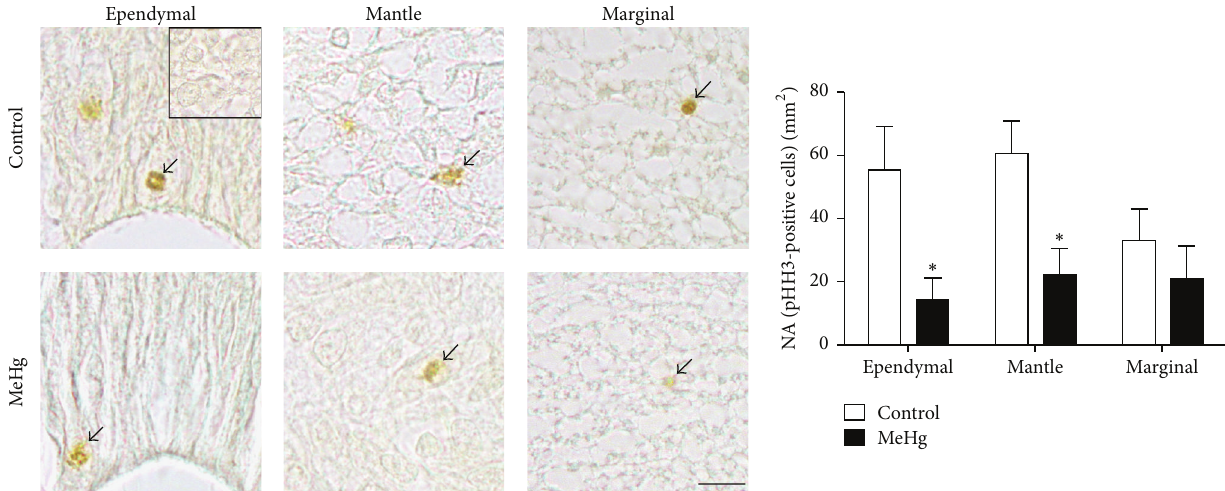
Figure 3: Effects of MeHg on the spinal cord layers of embryos at E10. Proliferating cells labeled with anti-phosphohistone H3 (arrows) were observed in the ependymal, mantle, and marginal layers of the control and MeHg-treated embryos. The square in the ependymal control embryo represents the negative control of immunohistochemical reaction. The accompanying graph displays the NA of proliferating cells, obtained by stereological analysis, in each layer of the spinal cord. Data are presented as mean ± SEM. ∗ 𝑃 < 0.05 . Scale bar: 10 𝜇